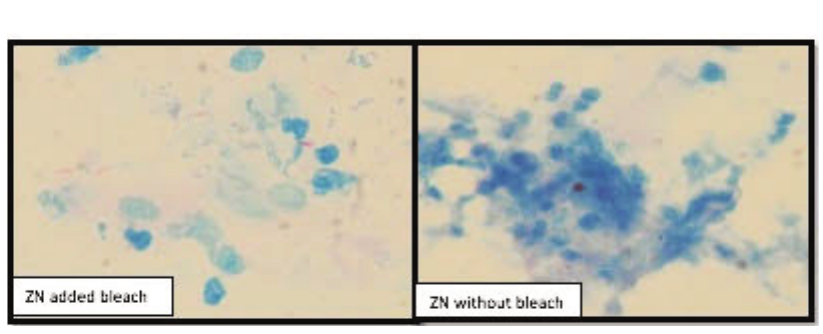
Figure 2. The smear’s result from added 1% bleach with ZN (left) and ZN staining only (right) from same specimen. We can see the background of 1% bleach is clearer than ZN only, so we can find the bacilli more